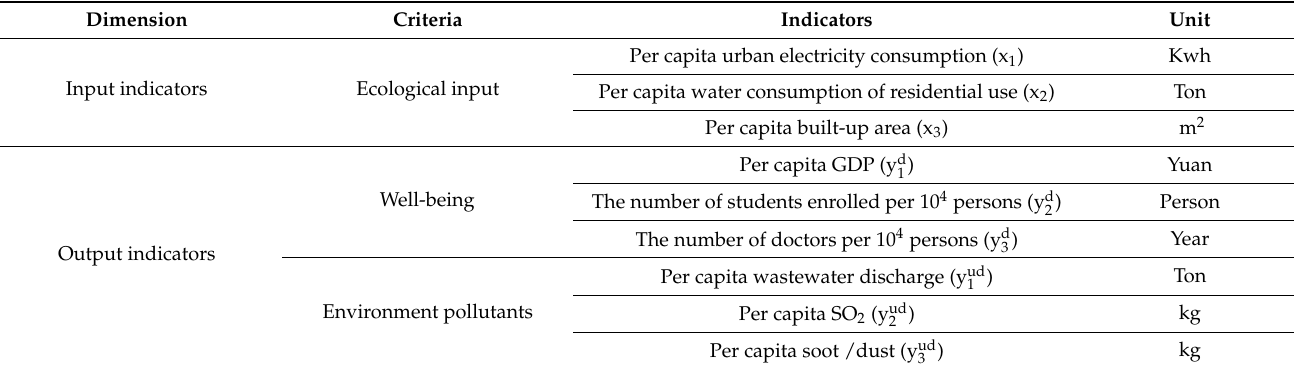
Table 1. The indicator descriptions of the EWP evaluation.